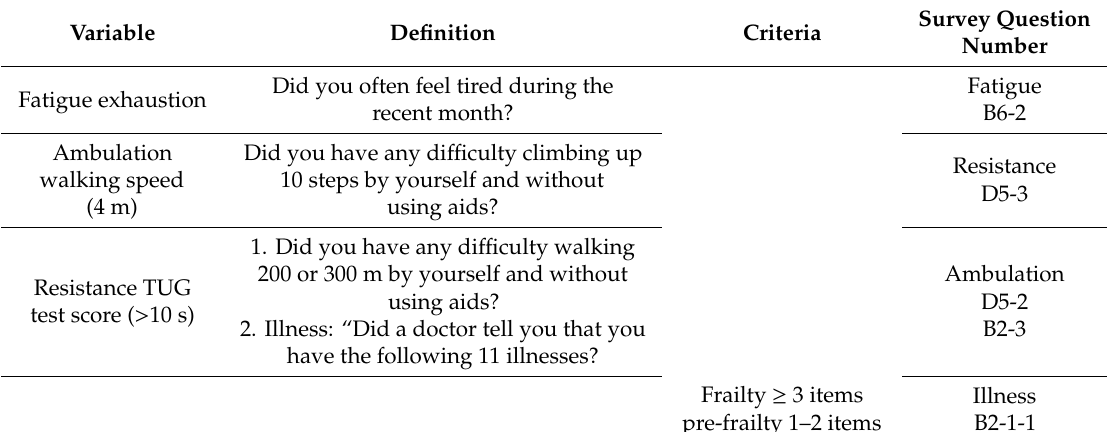
Table 2. The definition and standards of the 5 FI (Frailty Index) components for the frailty scale.